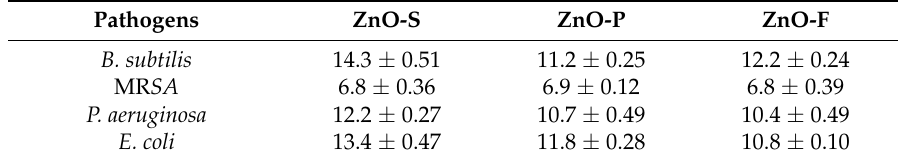
Table 3. Mean inhibition zone (mm) of synthesized ZnO-NPs against different pathogens.